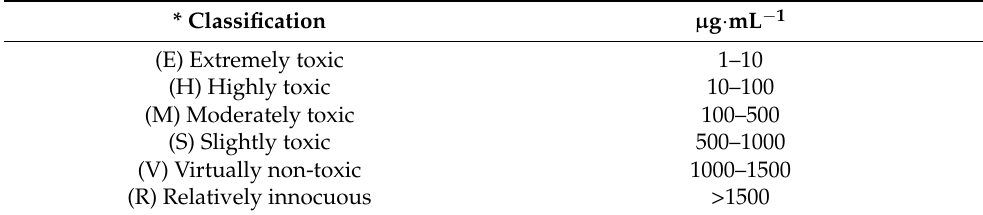
Table 1. Classification of extracts’ toxicity to A. salina